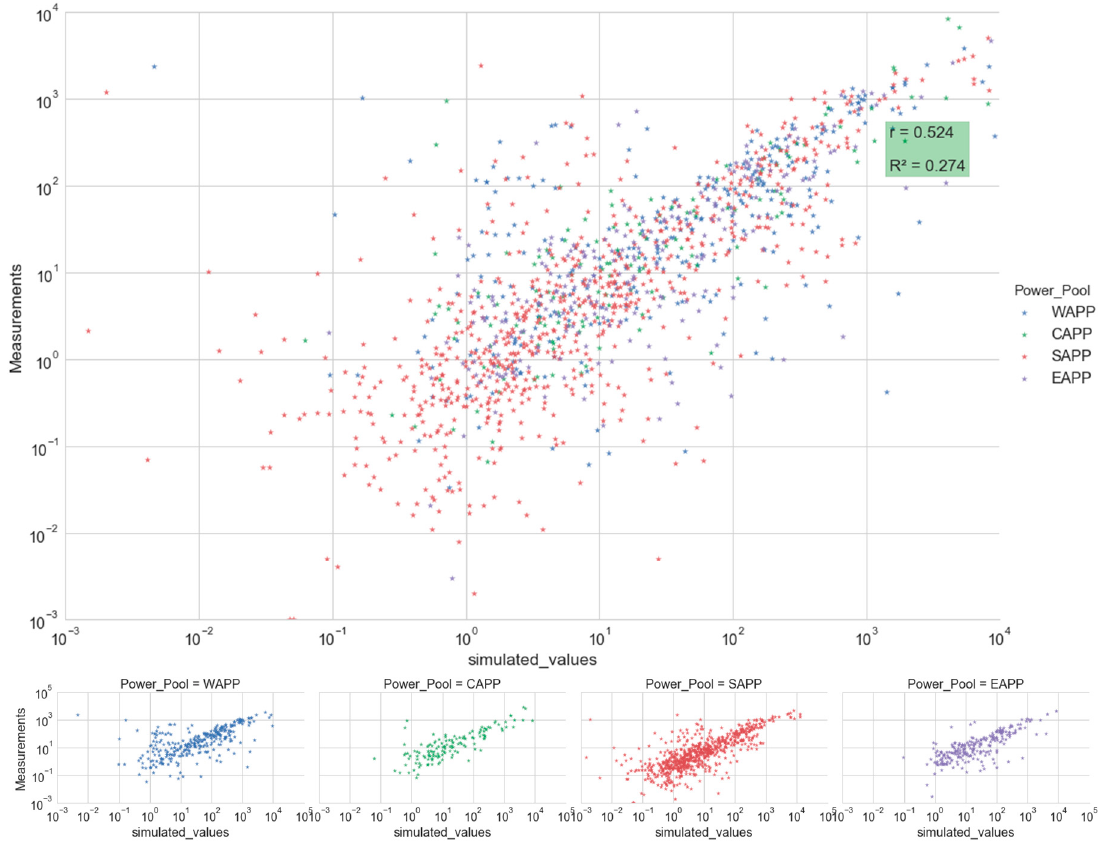
Figure 5. Observed (GRDC measurements) vs. simulated (LISFLOOD) scatter plots; aggregated (above) and by power pool (below); values are in m 3 /s. Table 2. Performance assessment of the two simulated discharge